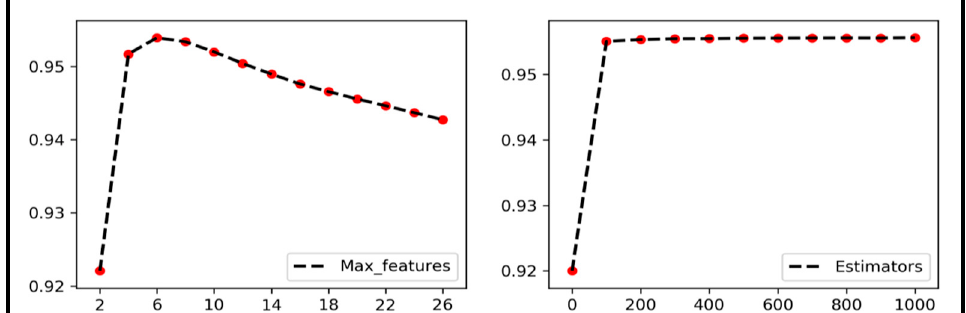
Figure 6. Cascade forest parameter optimization results. The red dot represents the integer value of the parameters(i.e., Max_features and Estimators). the parameters(i.e., Max_features and